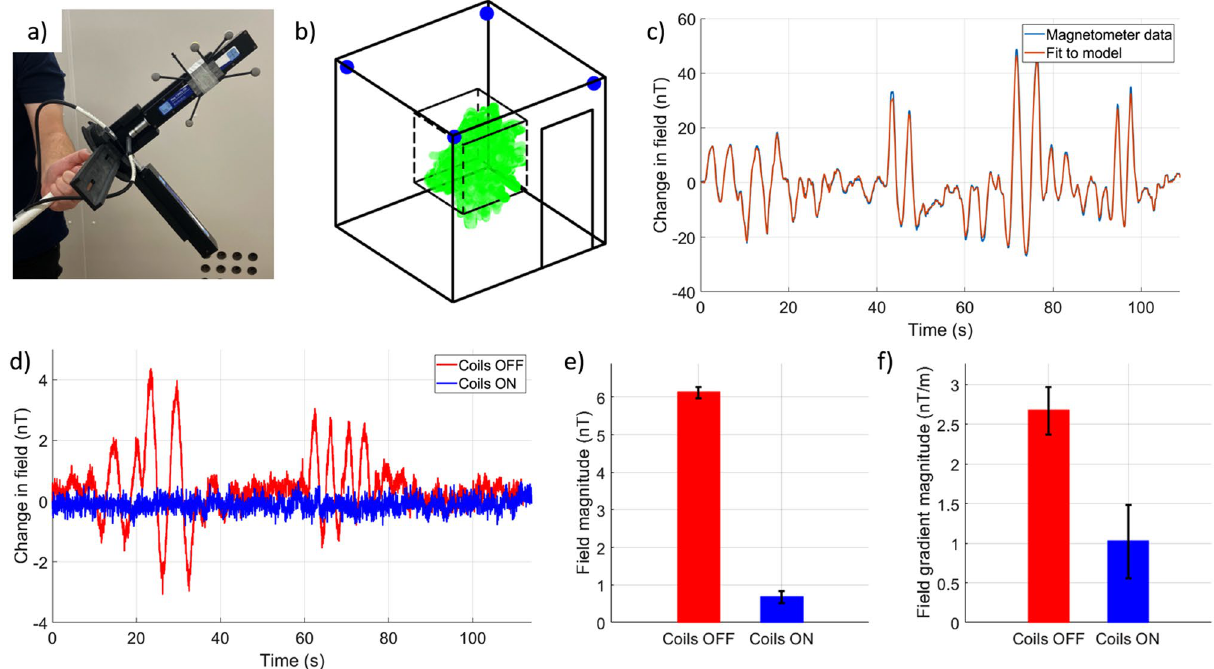
Figure 4. Active compensation of the remnant magnetic field using a field mapping method. ( a ) Two tri- axial fluxgate magnetometers attached to a plastic stick. A series of five infrared reflective markers are also attached to the stick allowing optical tracking of the position and orientation of the sensors within the MSR. ( b ) Schematic of the field mapping setup. The tracking cameras are mounted in the corners of the MSR and highlighted in blue. The dashed black volume shows the central cubic metre volume within which the stick was moved. The green highlighted marks show the path which the fluxgate magnetometers followed during the field mapping process, covering most of the central cubic metre of the MSR. ( c ) Magnetometer data from a single component of one triaxial sensor measured when a single coil was activated. By combining the data from all magnetometers with the optical tracking data a spherical harmonic model can be used to approximate the strength and spatial variation of the field produced by each coil. ( d ) The red trace shows the magnetic field measured by one magnetometer in the MSR with all coils switched off. The magnetic field model of each coil was used to calculate coil voltages which produce the required nulling field. Once voltages had been applied, the mapping was performed again. The blue trace shows the magnetometer data after nulling where similar sensor translations and rotations produce little to no change in the measured field. ( e ) Field mapping and nulling was repeated 8 times. The bar chart shows a consistent remnant field following demagnetisation and a consistent reduction in the RMS magnitude of the three uniform field components found by the model when the compensation is applied. ( f ) A similar reduction is seen in the RMS magnitude of the five field gradient